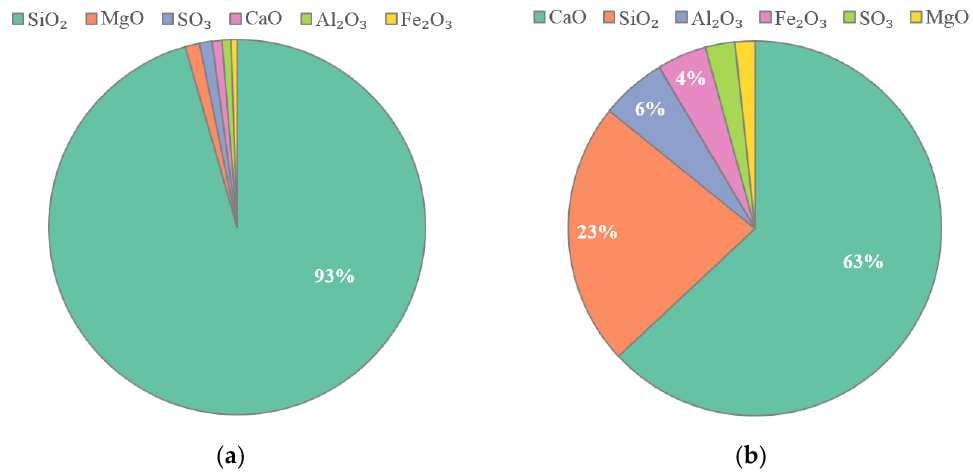
Figure 1. Chemical composition of cementing materials: ( a ) Silica fume; ( b ) Cement.